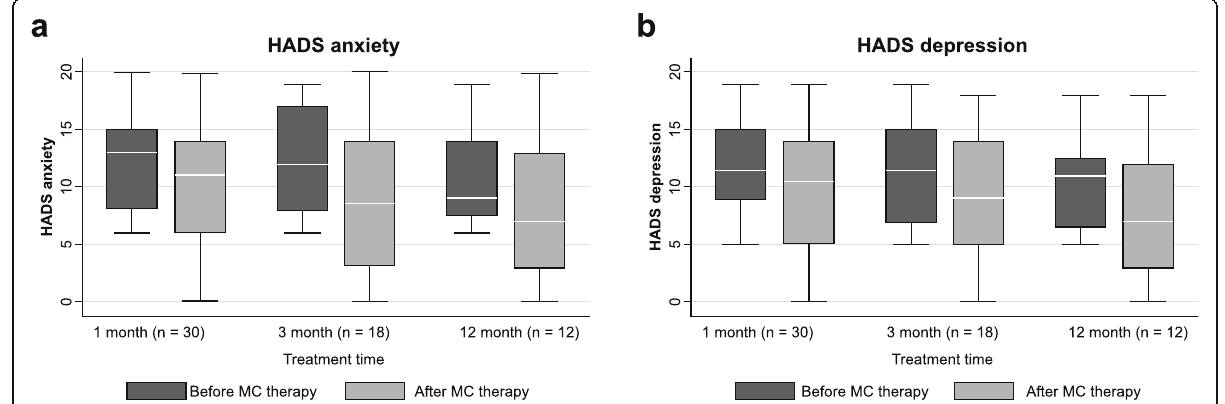
Fig. 5 Hospital Anxiety and Depression Scale at 1, 3, and 12 months. a HADS anxiety and b HADS depression boxplots before and after MC therapy at 1, 3, and 12 months. No statistically significant improvements were registered for comparisons at 1, 3, and 12 months (P < 0.01). The boxes contain the middle 50% of the values; the thick white lines indicate the median; the whiskers connected by dashed lines to the boxes mark the minimum and maximum values except when there are outliners, which are specifically indicated by circles. HADS hospital anxiety and depression scale, MC medical cannabis